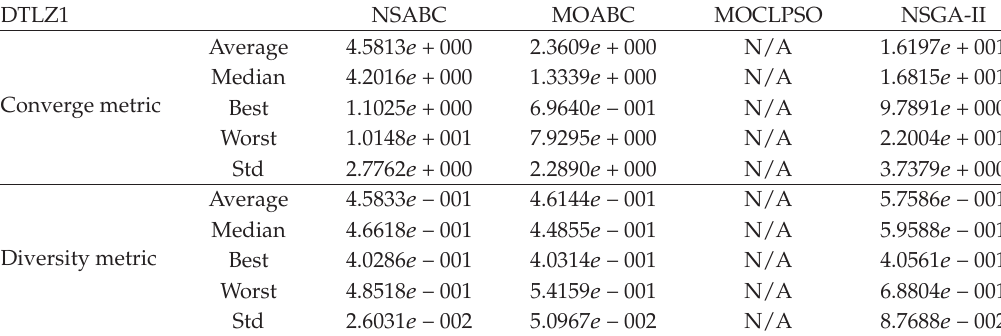
Table 16: Comparison of performance on DTLZ1 after 20000 FEs.